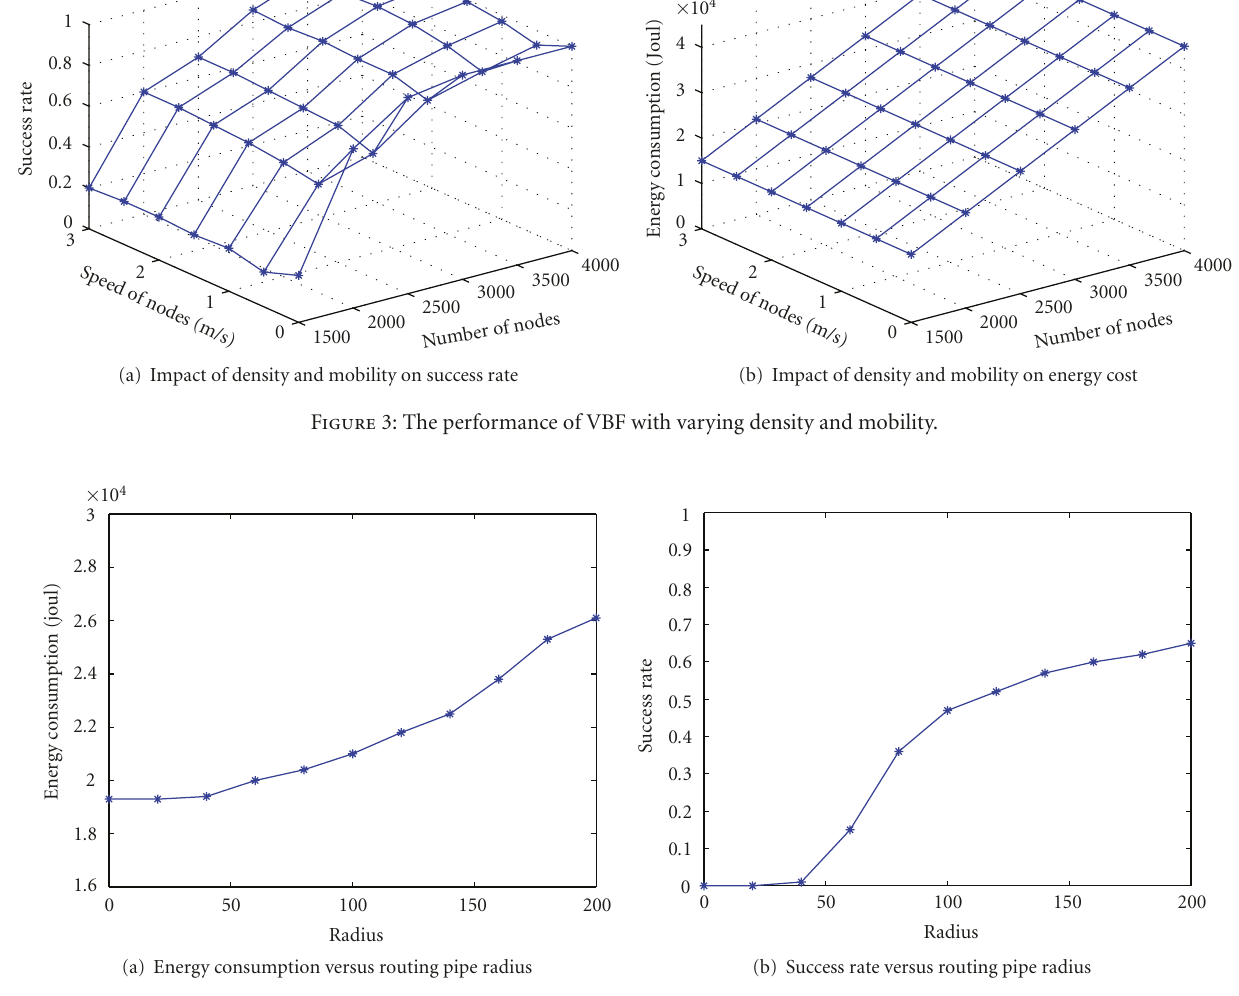
Figure 4: The performance of VBF with varying routing pipe